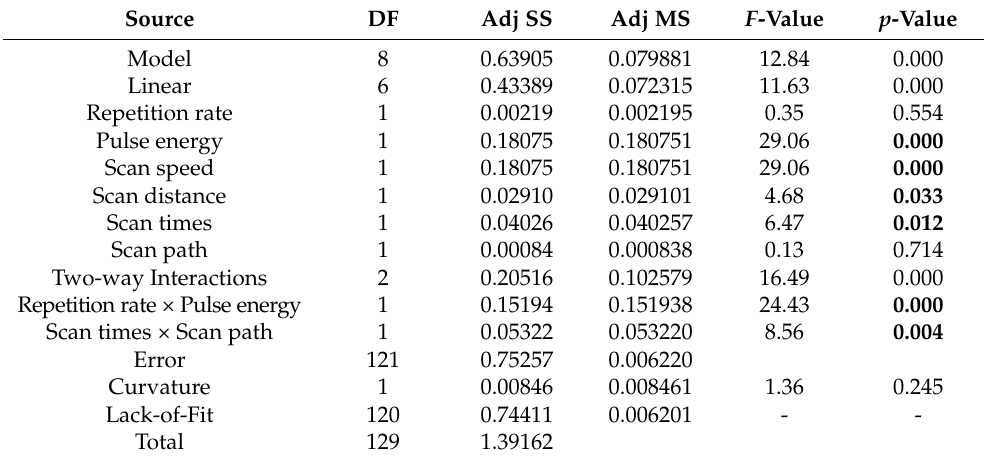
Table 3. ANOVA table for pocket Ra (µm).